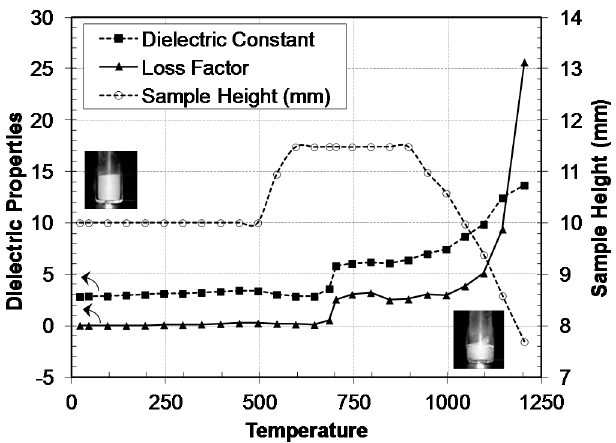
Figure 2. Dielectric properties of ceramic frit at microwave frequencies during the heating process up to 1200 °C.